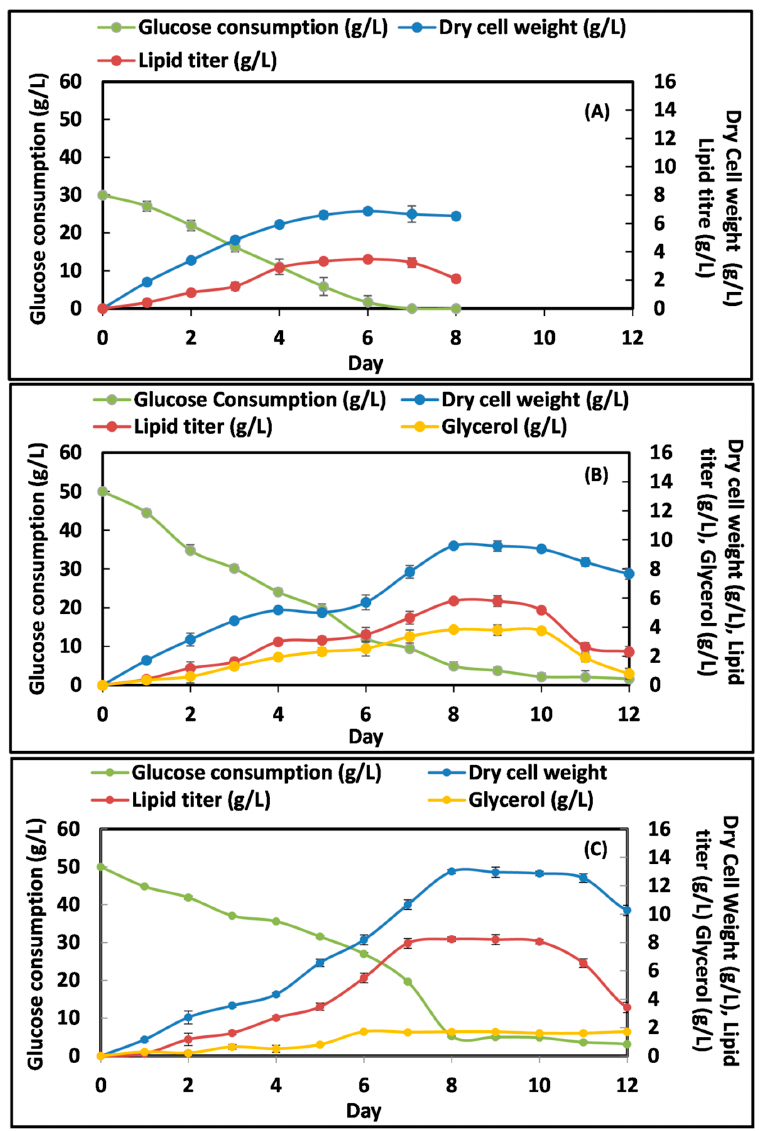
Figure 2. Batch cultivation experiments of R. toruloides 3641 for DCW (g/L), lipid titer (g/L), glucose consumption (g/L) and glycerol production (g/L) under nutritional stress conditions ( A ) control: 3% glucose, 0.5% (NH 4 ) 2 SO 4 ( B ) N-sufficient: 5% glucose, 0.5% (NH 4 ) 2 SO 4 ( C ) N-limited: 5% glucose, 0.12% (NH 4 ) 2 SO 4.